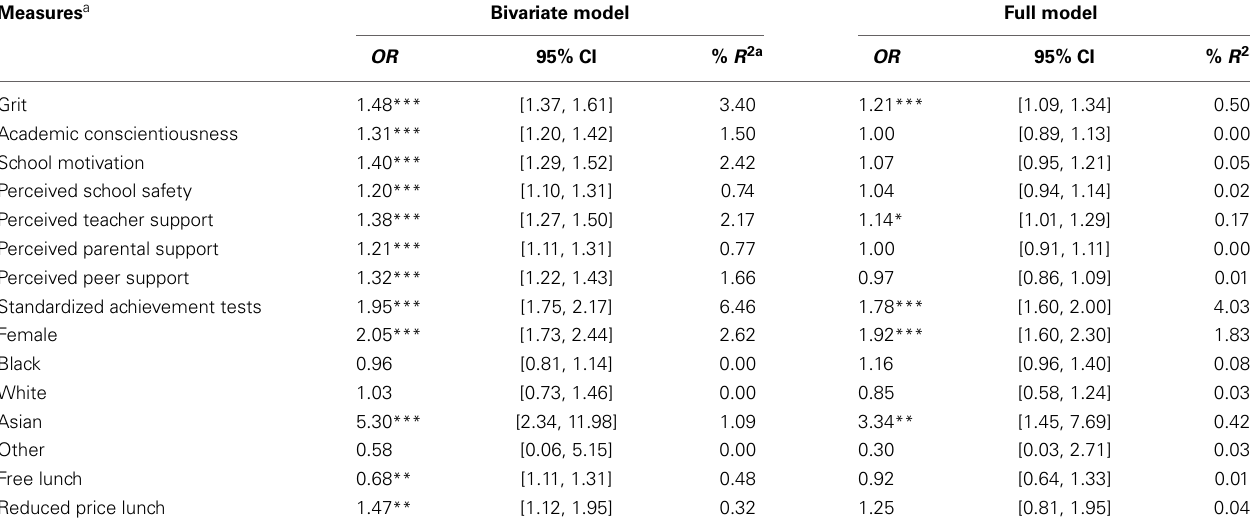
Table 3B | Bivariate and full logistic regressions predicting high school retention (Study